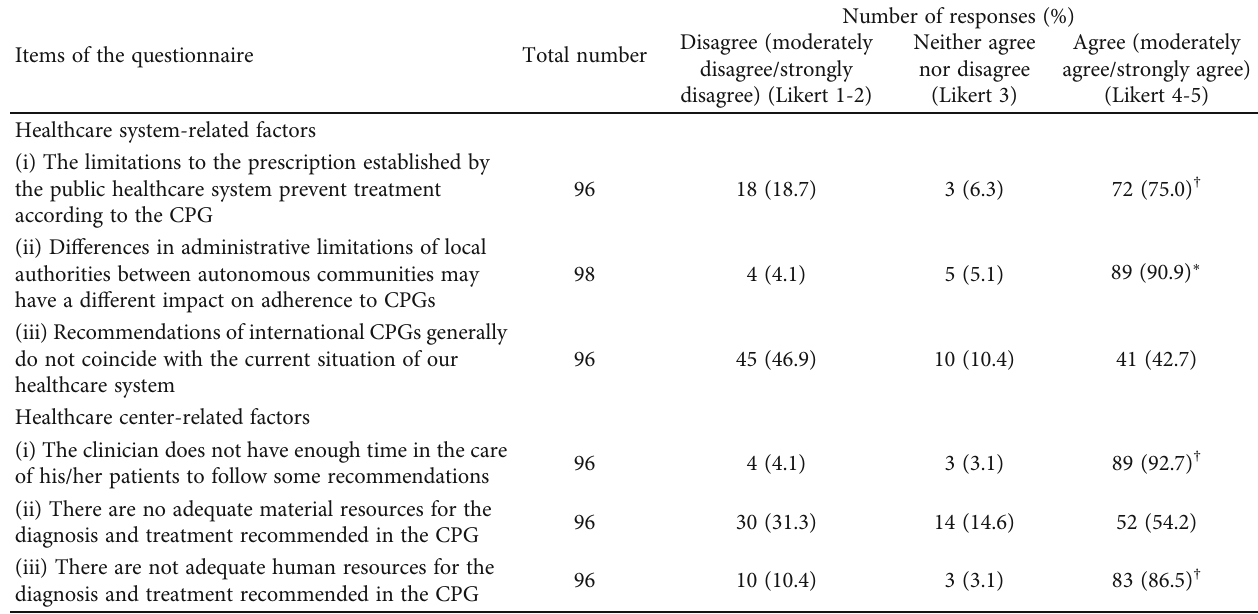
Table 2: Factors related to the healthcare system and the healthcare center.